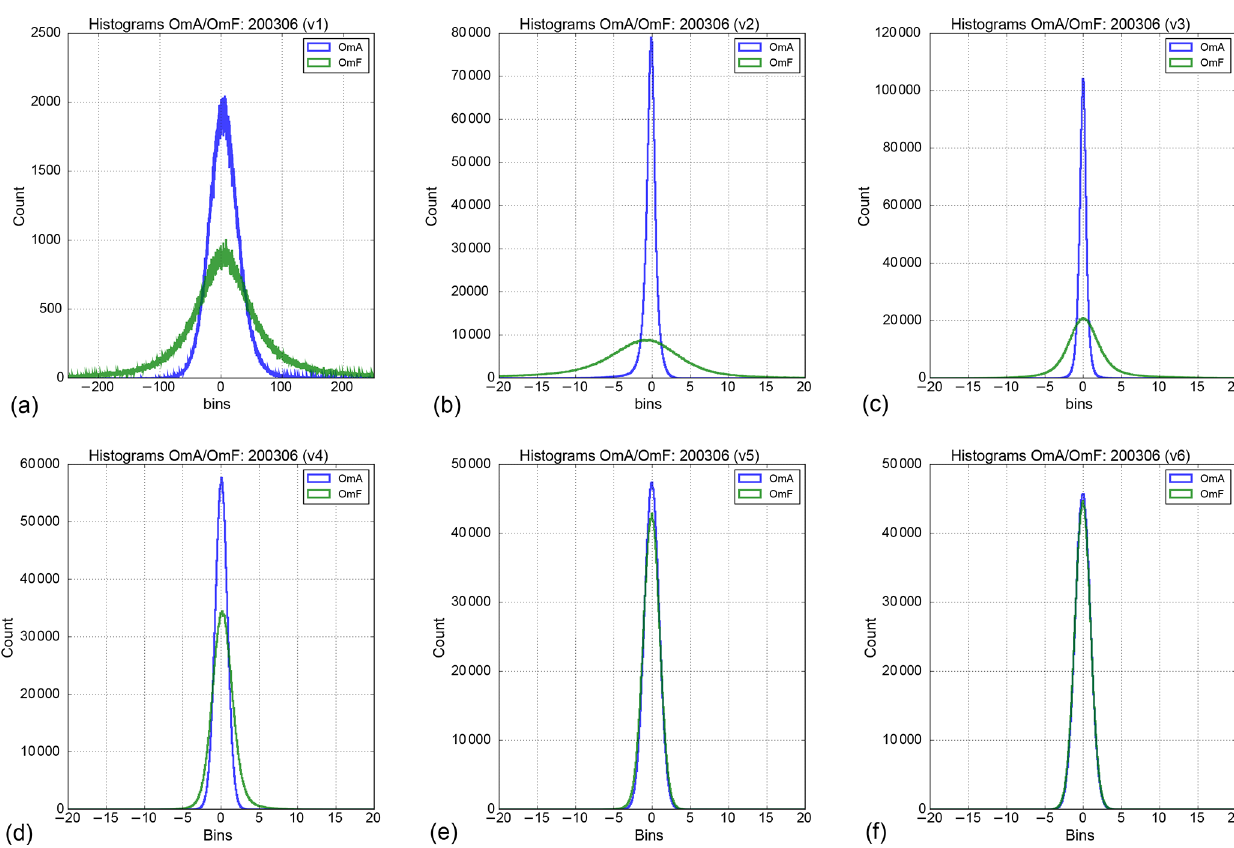
Figure 5. Histograms of observation minus analysis (OmA) – blue lines – and of observation minus forecast (OmF) – green lines – for the first leading eigenvectors v 1 to v 3 (a, b, d) and v 4 to v 6 (d, e, f) for the assimilation of S4 during the month of June 2003. Note that the y axis is variable for each eigenvector, while the x axis is different for v